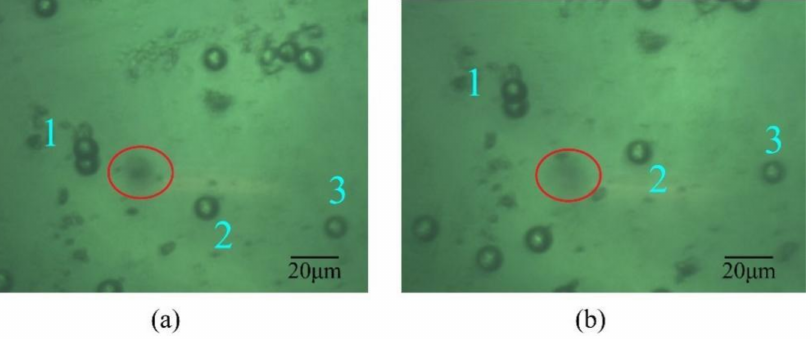
Figure 7. Trapping process of one 10 µ m-diameter SiO 2 in air. ( a ) The silica is trapped stably; ( b ) Process of the micro-particle’s cavity moving upward, particles 1, 2, 3 are used as a control reference.